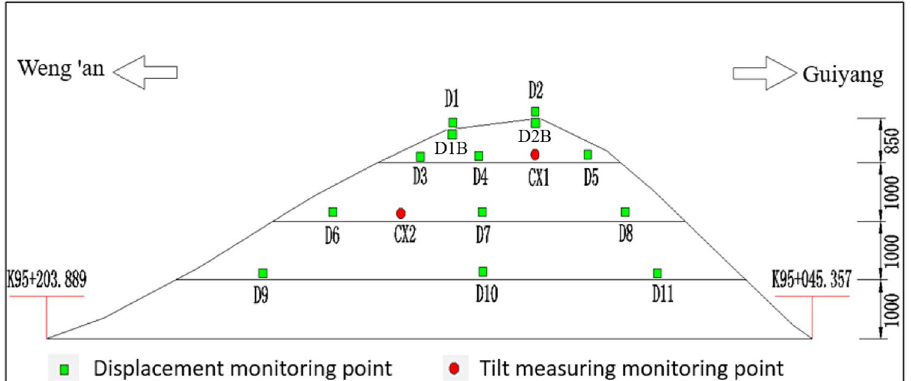
Figure 2. Deformation monitoring point layout of the Damao